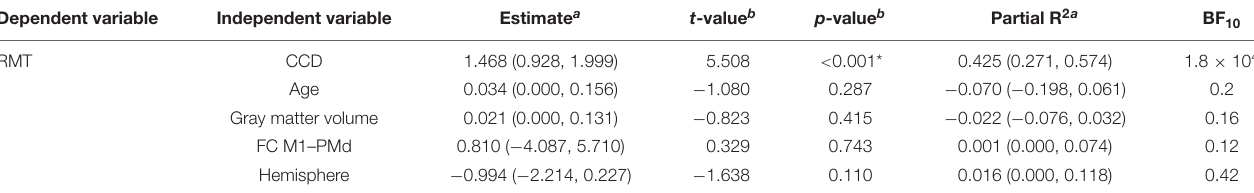
TABLE 4 | Combined linear mixed model for both